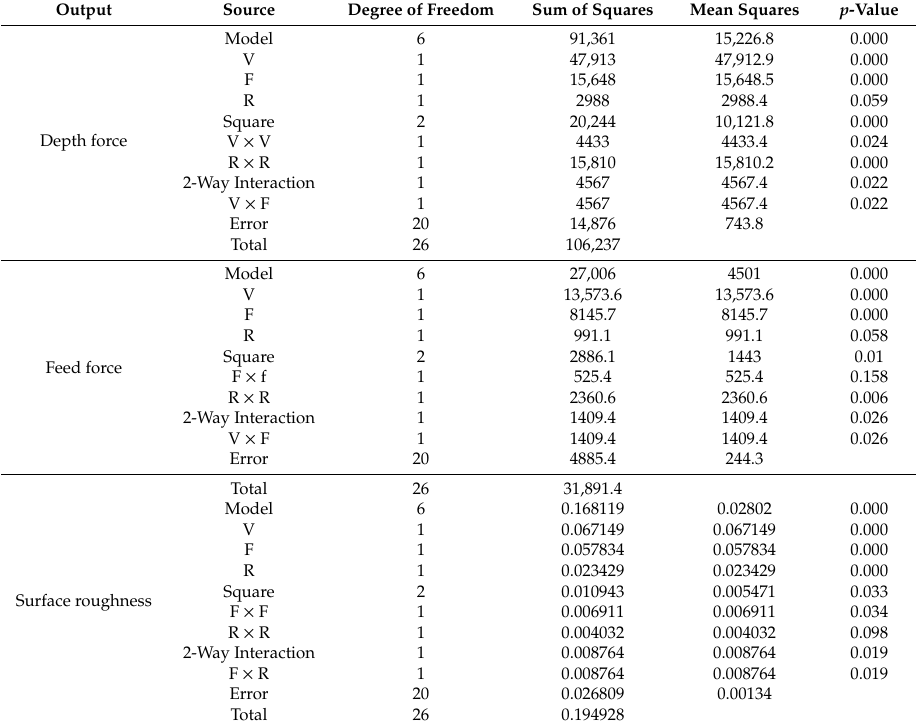
Table 6. Results of the ANOVA for all selected output